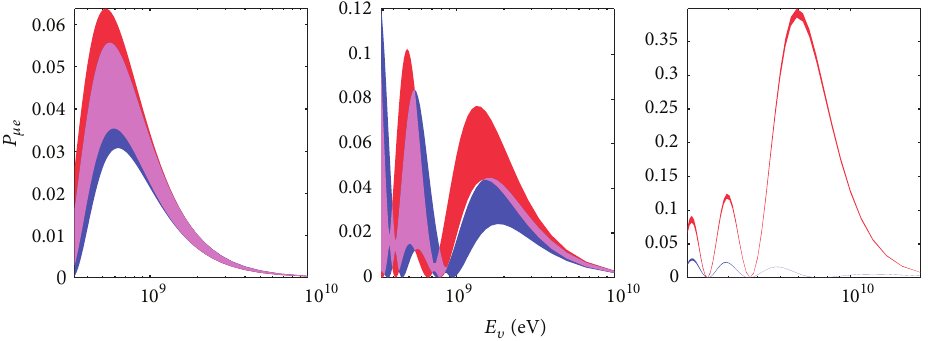
Figure 13: The neutrino oscillation probability 𝑃 𝜇𝑒 at baselines of 295 (left), 810 (middle), and 7500 km (right) as a function of the neutrino energy. The red (blue) band corresponds to the normal (inverted) mass hierarchy and the band width is obtained by varying the value of 𝛿 . The probabilities for 𝑃 𝜇𝑒 look similar with the hierarchies interchanged. Note the different scales of the axes.